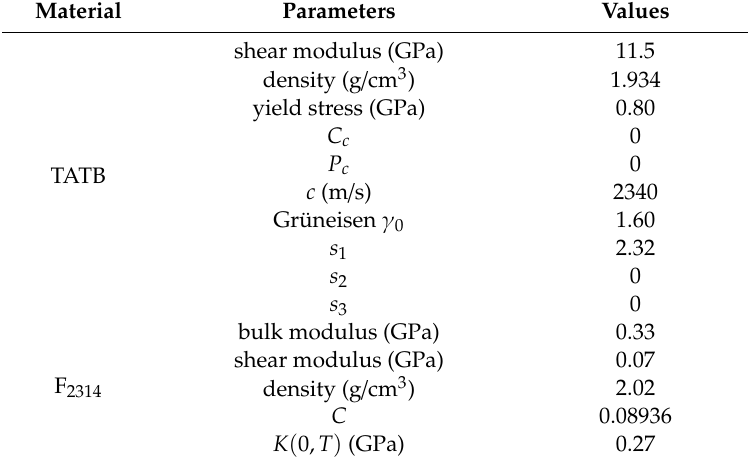
Table 1. The model parameters of Trinitro-1,3,5-benzenetriamine (TATB) 1 and F 2314 2 .